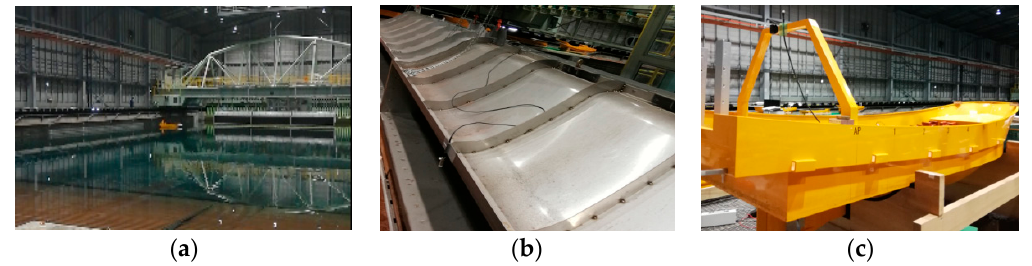
Figure 15. Photographs of the ( a ) experiment tank, ( b ) wind-making machine, and ( c ) ship model.